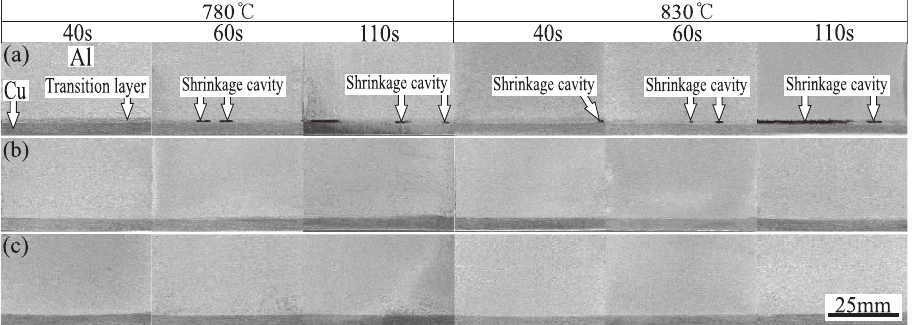
Figure 2: Recombination effects of Cu and Al under horizontal pouring: (a) air jet cooling, (b) spraying cooling, and (c) water injection